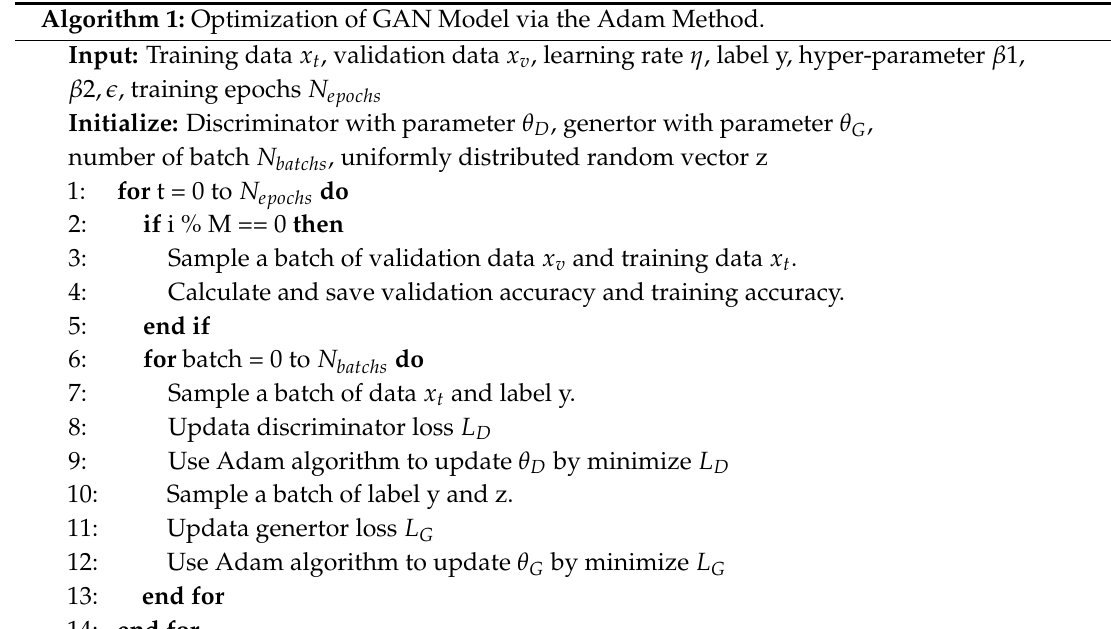
Algorithm 1: Optimization of GAN Model via the Adam